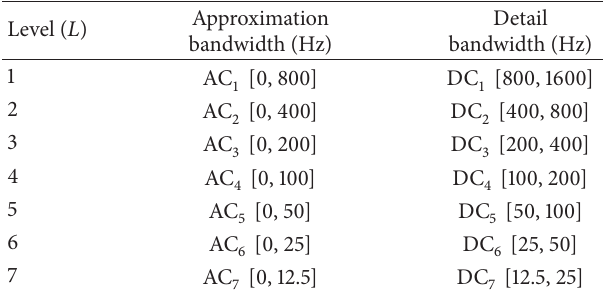
Table 1: DWT decomposition level frequency bands for a sampling frequency 𝑓 𝑠 = 3200